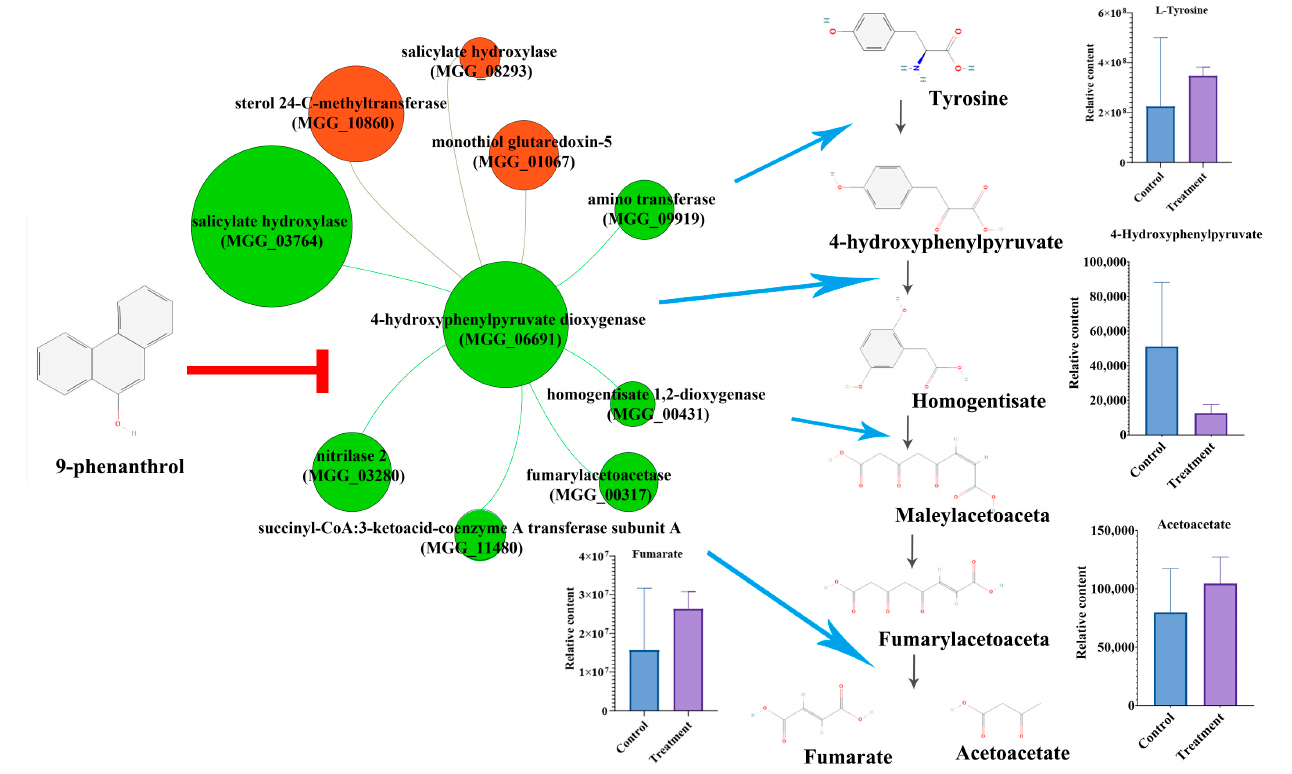
Figure 6. HPPD interacted with gene network and metabolites on the tyrosine degradative pathway. Red nodes represent upregulated genes, and green nodes represent downregulated genes. The size of the node means the absolute value of gene expression. The blue arrows indicate the gene encoding enzyme involving catalyzed reaction among tyrosine degradative pathway. The histograms beside compounds mean the relative contents from metabolome data.